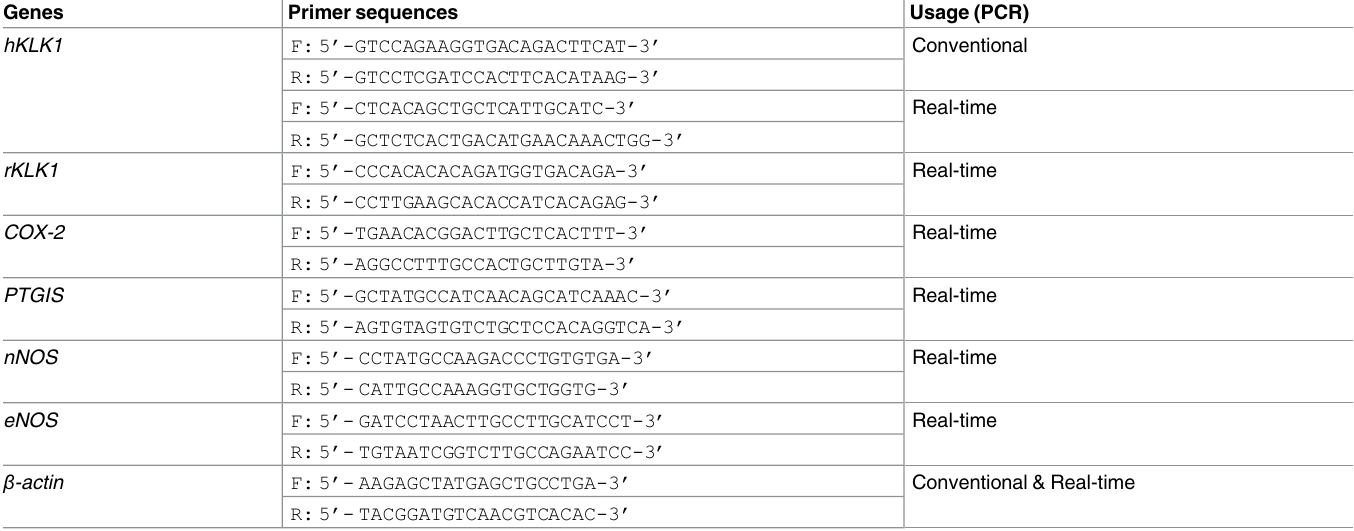
Table 1. Primers used in conventional PCR and Real-time RT-PCR.